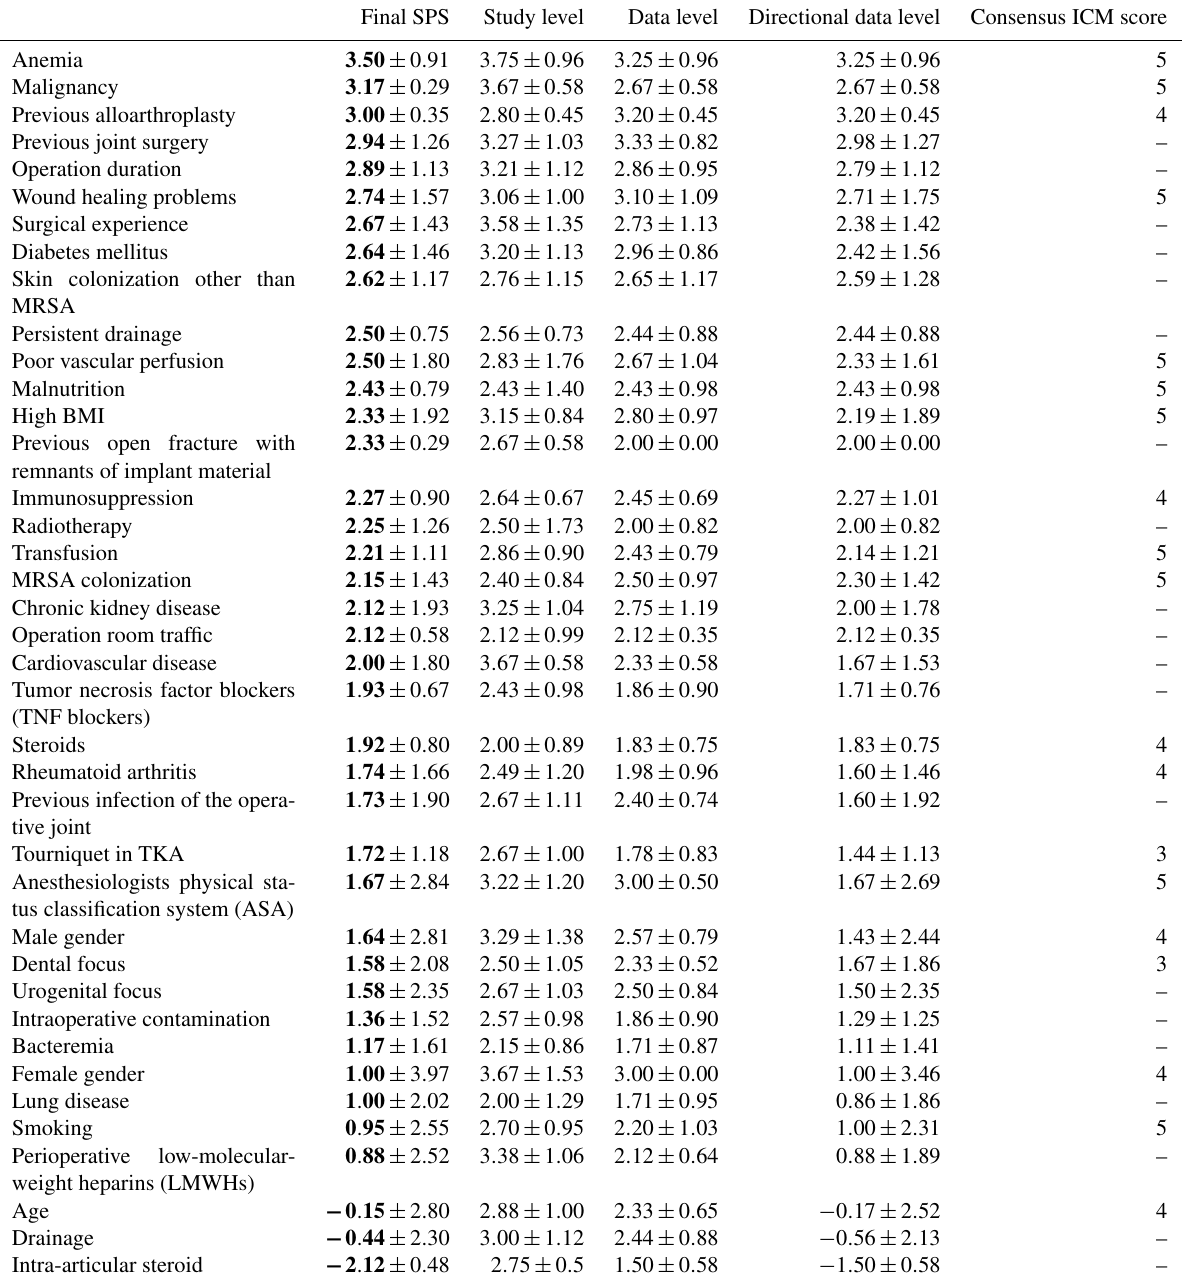
Table 3. Pilot study group I: risk